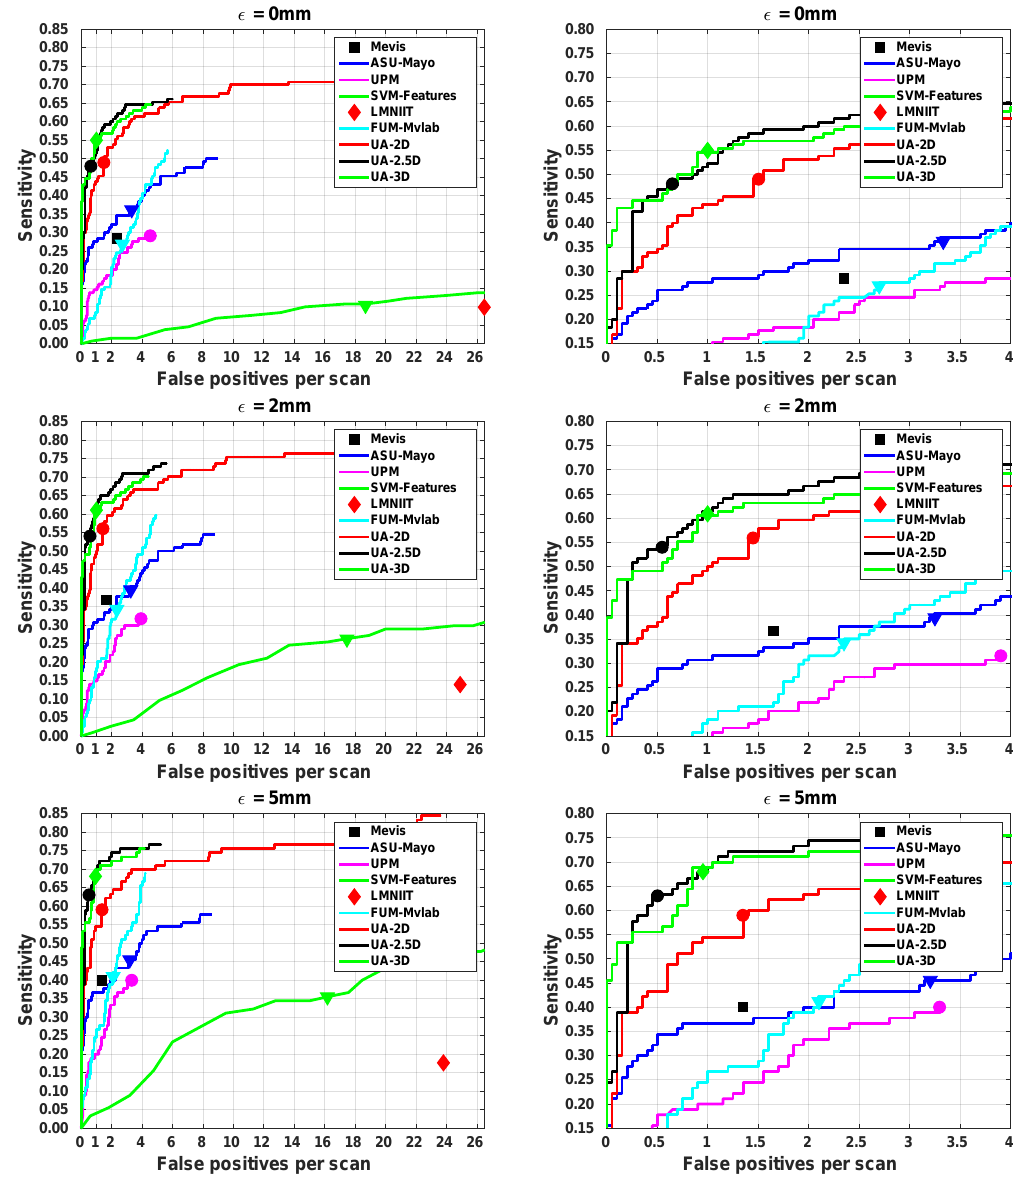
Figure 4. Free-response Receiver Operating Characteristic (FROC) curves of the different methods proposed in this work, together with the results of other methods submitted to the Computer Aided Detection of Pulmonary Embolism (CAD-PE) challenge [14], using (cid:101) of 0, 2, and 5 mm. The x-axis represents the false positive rate per scan and the y-axis is the per embolus sensitivity. ( Left ) The complete range of false positives per scan. ( Right ) Zoomed in the range 0–4 false positives per